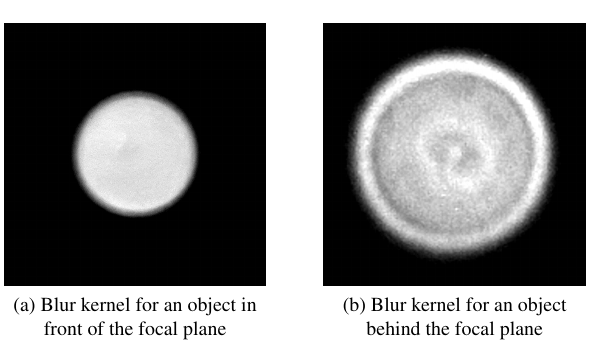
Figure 2. Displacements for two-dimensional grid warping. Thick blue line represents the exact edge location, white circles represent edge pixels, black circles represent pixels from the edge neighborhood.